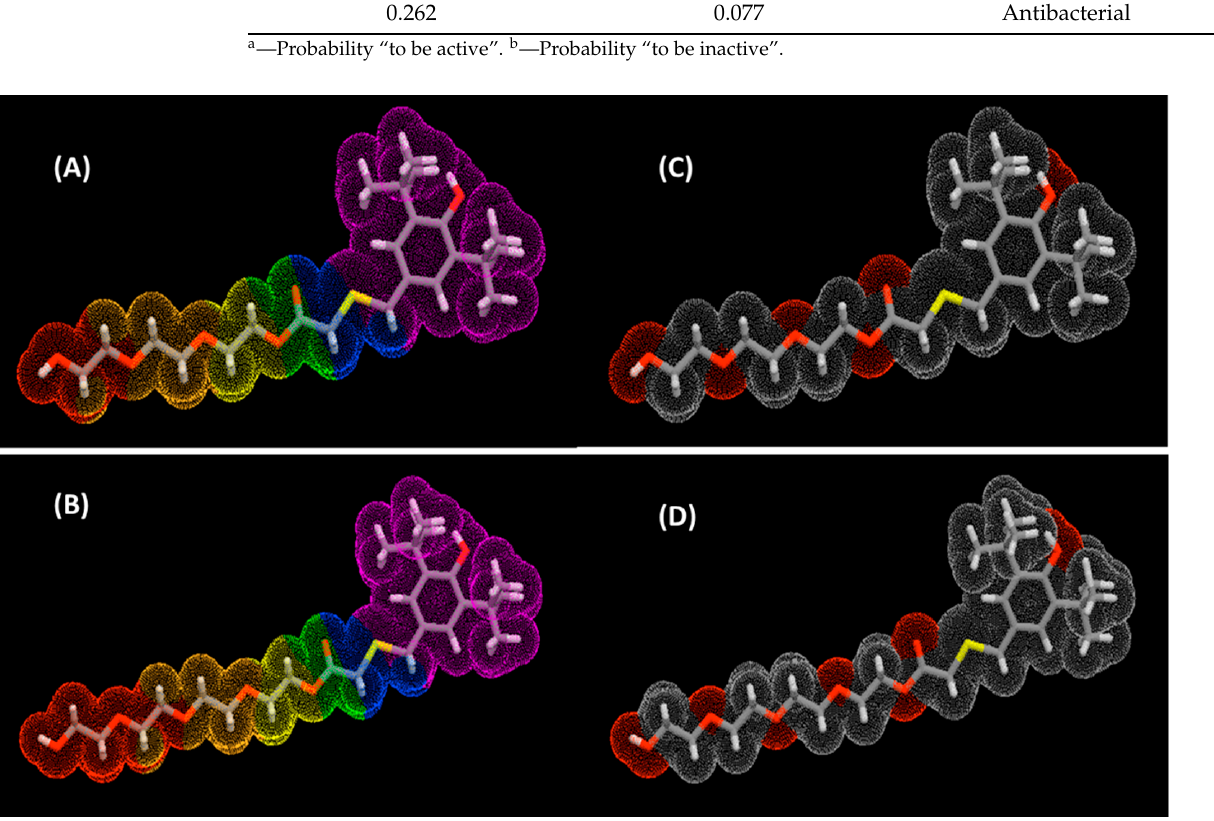
Figure 10. ( A , B ) Molecular lipophilicity potential (MLP); ( C , D ) polar surface area. Antioxidant values and other predicted bioactivities of the MPAO having Pa > 0.7 Table 4. Part of the predicted biological activity spectra of the MPAO based on PASS prediction suggest that nanomaterial functionalized with MPAO could display enhanced activities software. compared to nanoparticles without functionalization. This is owing to its biocompatibility, which can assist in the drug transportation system and bioimaging. Biological testing verified the predicted